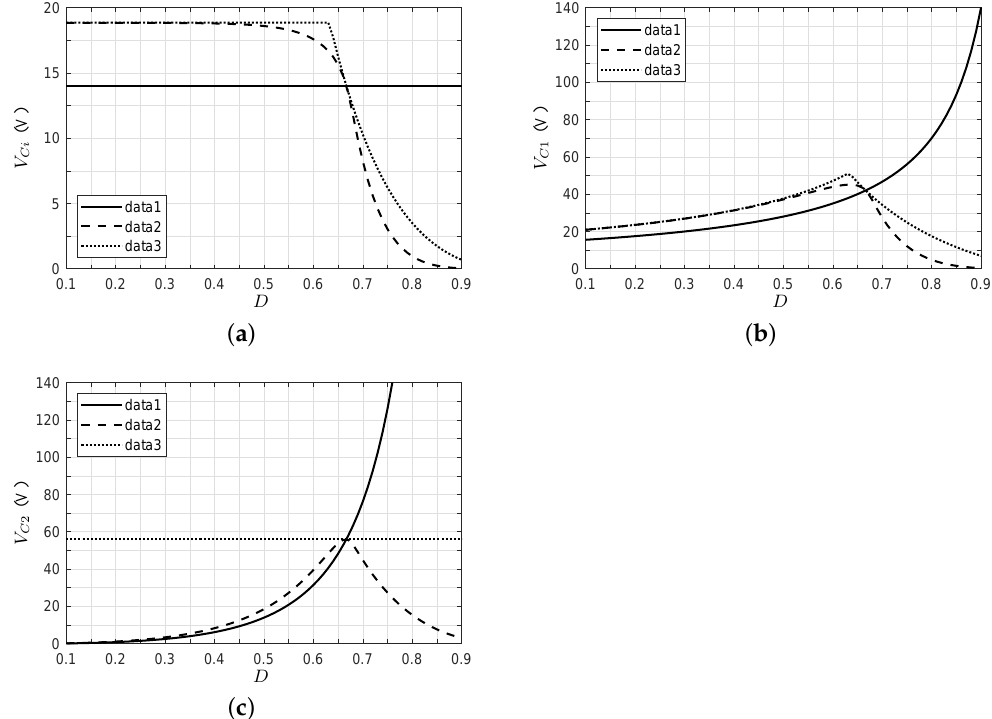
Figure 9. Capacitor voltages in the steady state of the proposed converter (data 1: voltage converter appl; data 2: PV appl, resistive load; data 3: PV appl, clamped voltage). ( a ) Input port. ( b ) Capacitor C 1 . ( c ) Output